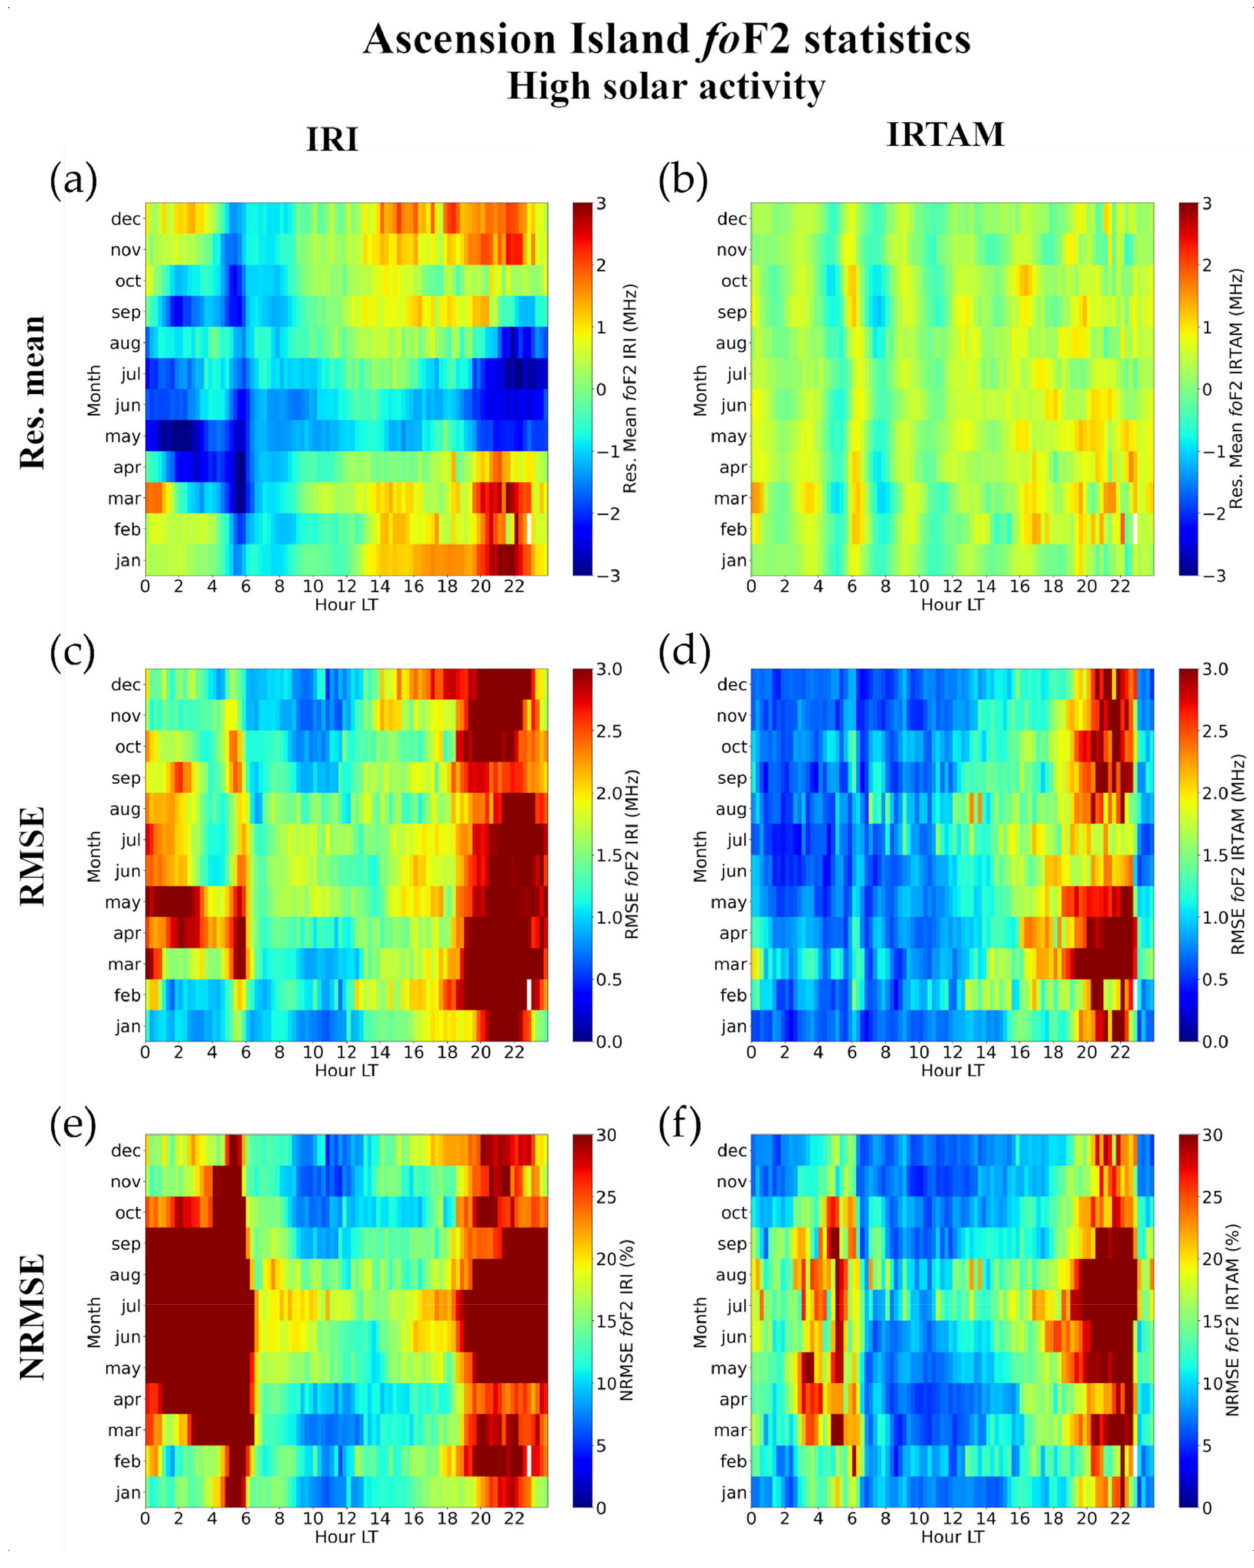
Figure 9. Same as Figure 7 but for HSA